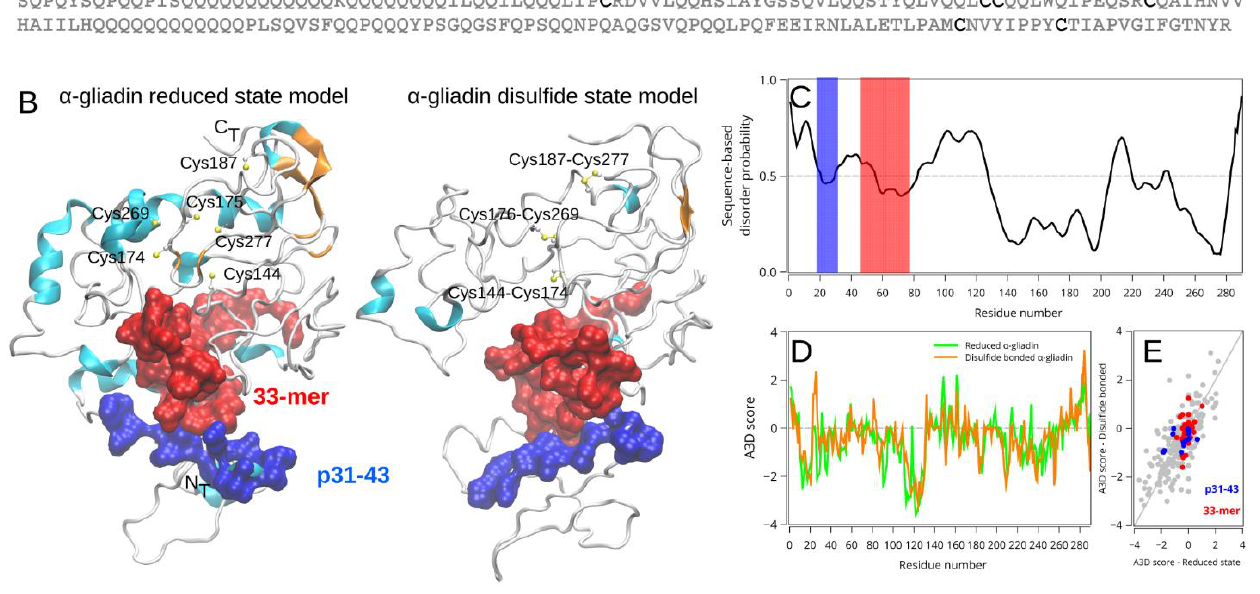
Figure 2. Structural characterization of the reduced and oxidized states of α-2-gliadin of Triticum aestivum . Primary sequence of wheat α-2-gliadin where the p31-43 (blue) and 33-mer (red) regions are highlighted ( A ). Tridimensional structure of α-2-gliadin in the obtained previously [19] and the new disulfide state model ( B ). The immunogenic regions are in surface representation using the same color reference as in panels A and C, and the cysteine pairs involved in disulfide bonds are marked for clarity. Sequence disorder prediction was calculated using the PrDOS server ( C ), and the aggregation propensity was calculated using AGGRESCAN 3D ( D ) for both oxidation states. The horizontal gray line in panel C marks the 5% threshold (false positive rate), while aggregation-prone regions have positive values, respectively. The per residue correlation between both oxidation states is shown in panel ( E ).